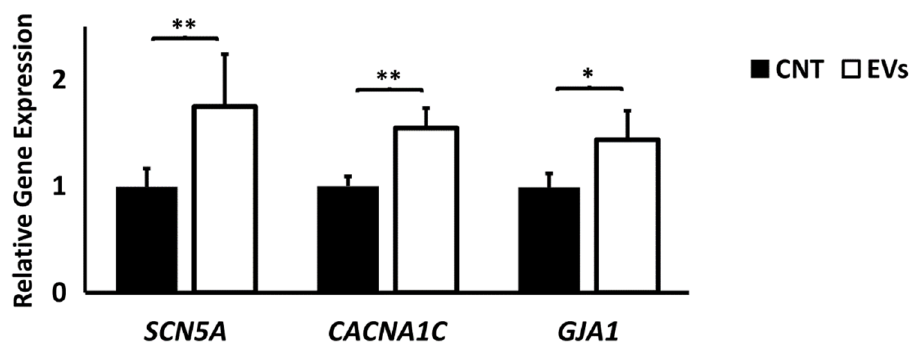
Figure 4. Relative gene expression results ( N = 9 in each group) normalized to GUSB and 36B4 housekeeping genes. Relative gene expression of SCN5A (** p < 0.01), CACNA1C (** p < 0.01), and GJA1 (* p < 0.05) was significantly higher in the CDC-EV treated group.